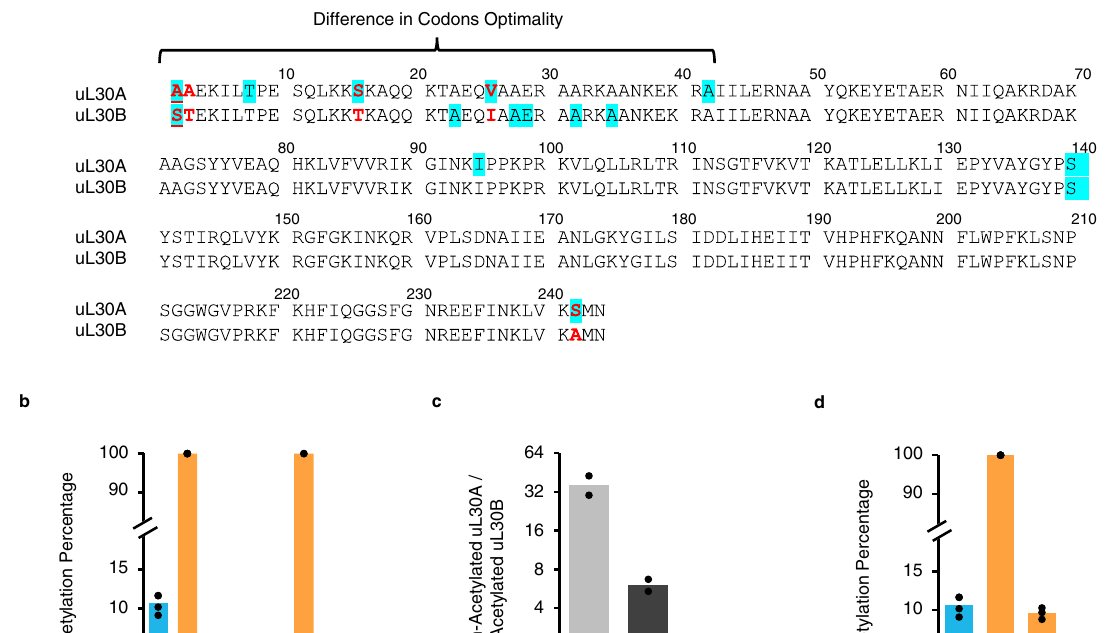
bottom. e Relative growth rates of WT and uL30B-Ant mutant after exposure to staurosporine. The results of the two-tailed t test assuming unequal variance are indicated on top. The number of biologically independent samples is indicated at bottom. f Translationindexof5longmRNAs(3945-6438nt)thatwerefound down regulated in ul30aa by RNA sequencing was analyzed by RT-qPCR in WT and uL30B-Ant.Theresultofthepairedtwo-tailed t testofthechangeinthetranslation of the indicated genesisshown on the right. g 18Sand 25SrRNA wasquanti fi ed by capillary electrophoresis and reported relative to WT. The number of biologically independentsamplesisindicatedatbottom. h Polysomepro fi lesofWTanduL30B- Ant. Curves are representative examples ofbiologically independent samples n =2 WT and n =4